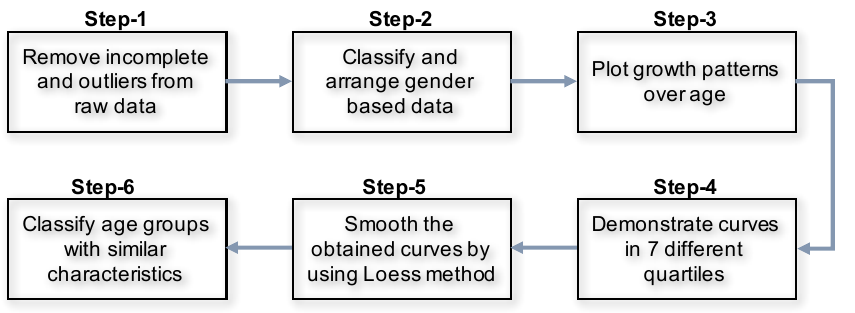
Figure 5. Steps to demonstrate growth pattern from remote healthcare data.